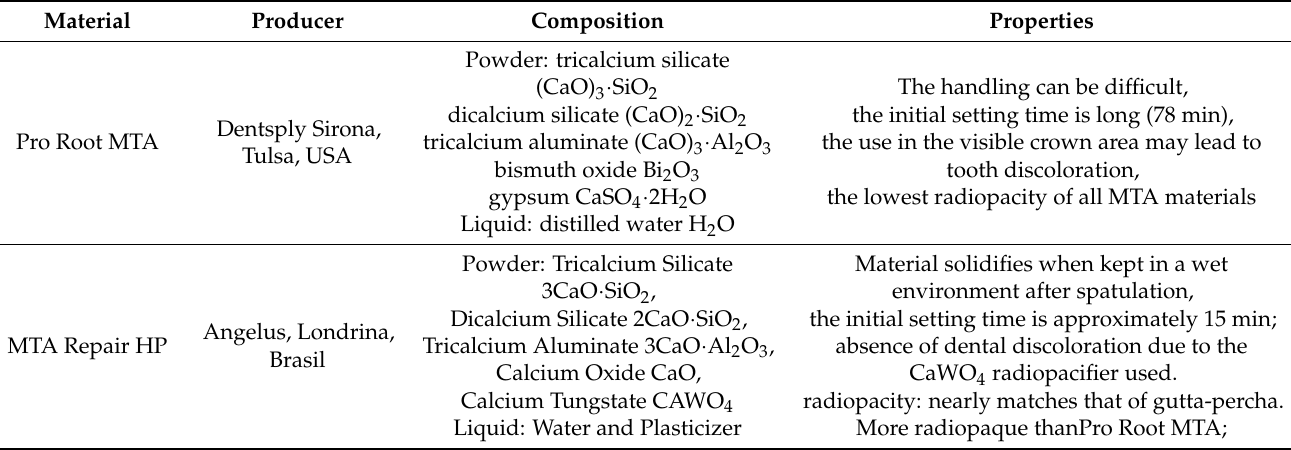
Table 1. Detailed manufacturer data on ProRoot MTA and MTA repair